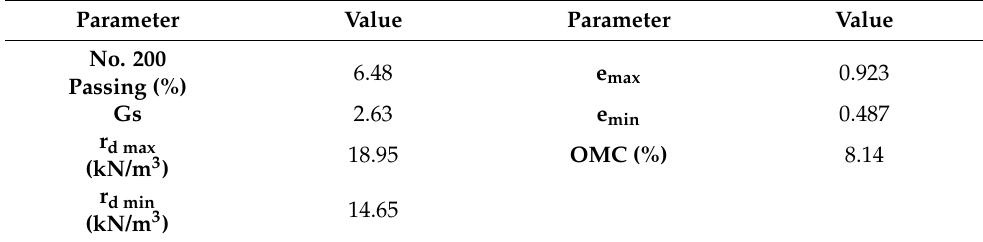
Table 2. Geotechnical index properties of the specimen (dense ground) used in this study.